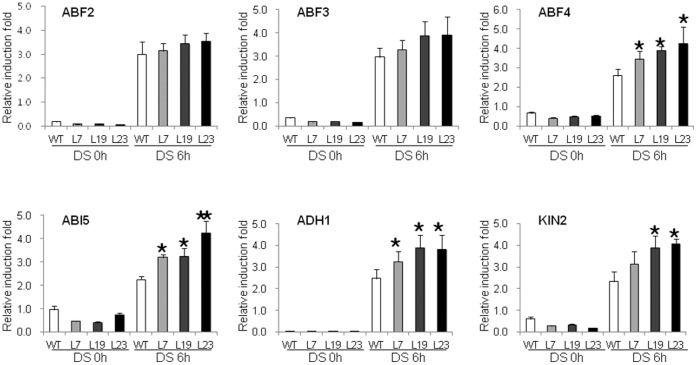
Real-time qRT-PCR analysis of drought-stress maker genes.Total RNA was extracted from the treated tissues and analyzed by real-time qRT-PCR. Light-grown, 4-week-old plants were dehydrated in a vinyl bag for 6 h. Induction patterns of various ABA- and drought-responsive genes (ABF2, ABF3, ABF4, ABI5, ADH1, and KIN2) were analyzed by real-time qRT-PCR. Data represent the fold induction of each gene by dehydration (6 h) relative to the control treatment (0 h). Mean values from three independent technical replicates were normalized to the levels of an internal control, actin mRNA. Asterisks indicate the significance of the difference from the values between the wild-type and the 35S:VrUBC1 Arabidopsis transgenic plants as determined by Student’s t test (*0.01 ≤ P<0.05, **P<0.01).